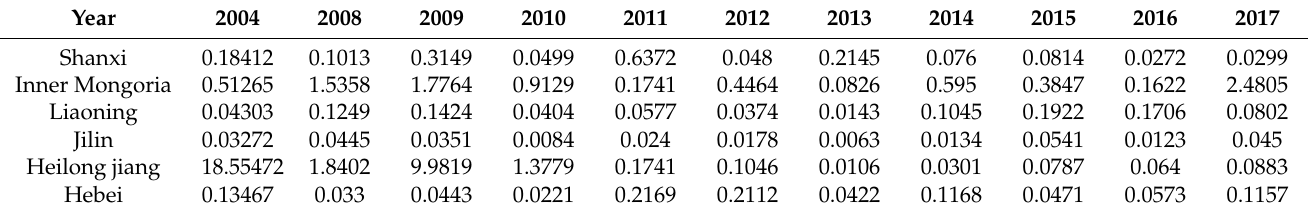
Table 2. Annual forest area data of forest fires in each province (unit: ten thousand hectares).